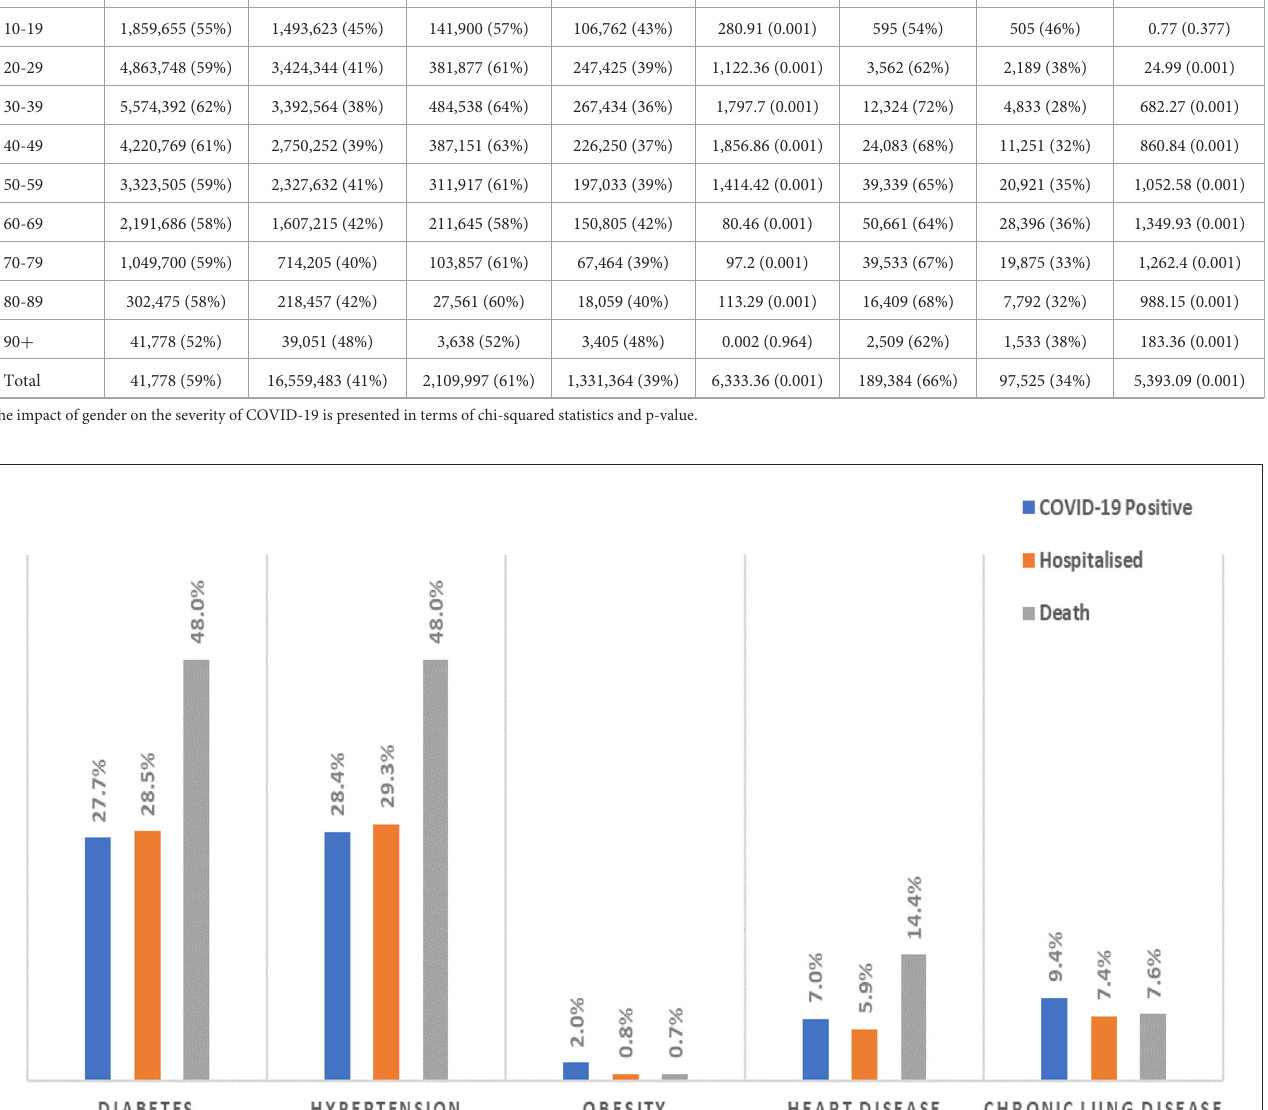
death were observed in patients with diabetes (OR: 2.39; 95%